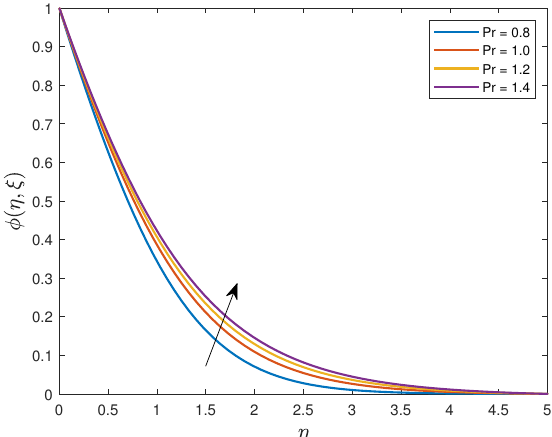
Figure 18. The influence of Pr on fluid concentration.